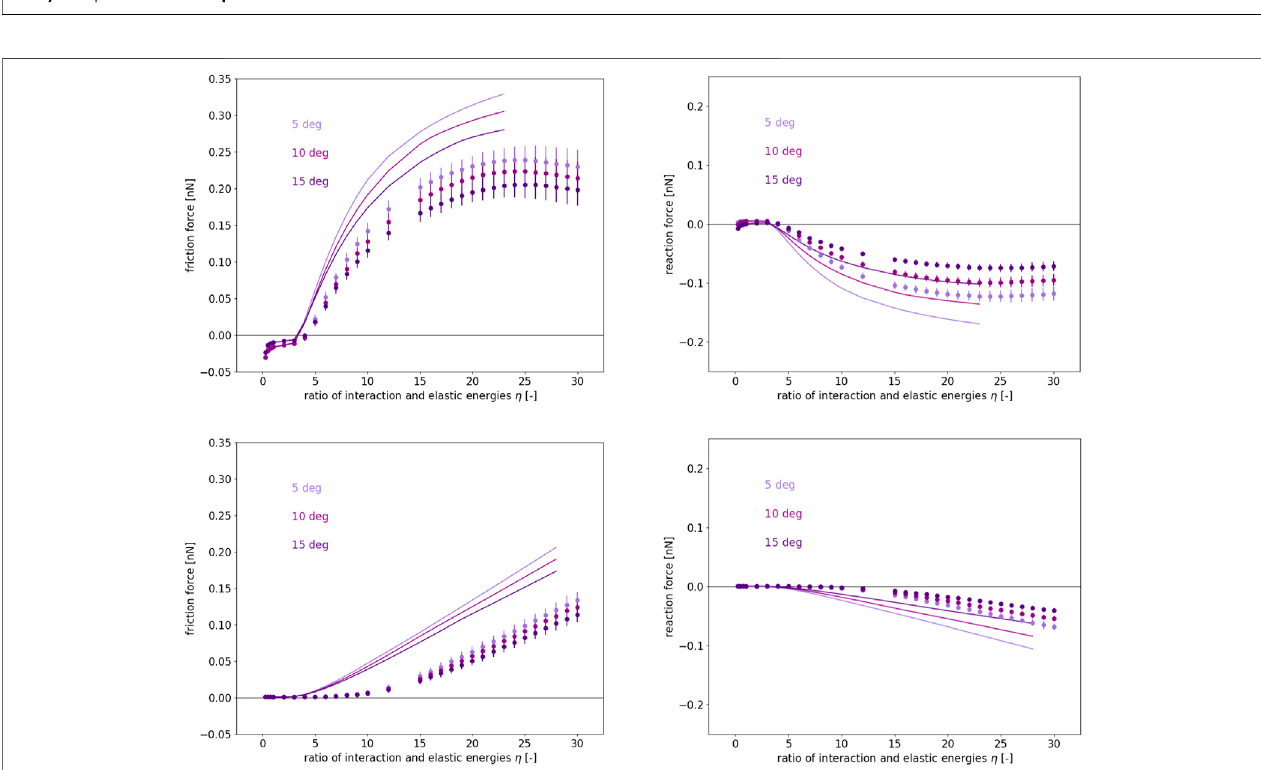
FIGURE 8 | As in Figure 7 , for three two-dimensional incommensurate sliding paths Φ (cid:2) 5, 10 and 15 deg, when using the 2D PT-model.